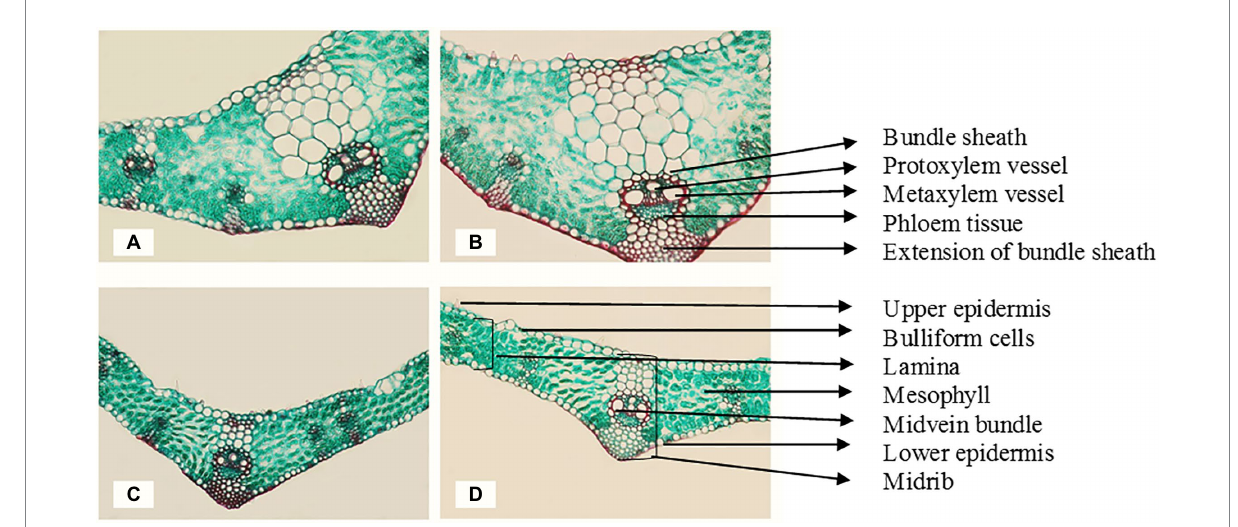
FIGURE 1 Transverse cross sections of the marginal part of the flag leaf blade at the main stem of wheat cv. Sakha 93 at the heading stage (X 300). (A) Control (from plants irrigated with normal tap water); (B) magnetic treatment (from plants irrigated with magnetized water); (C) seawater